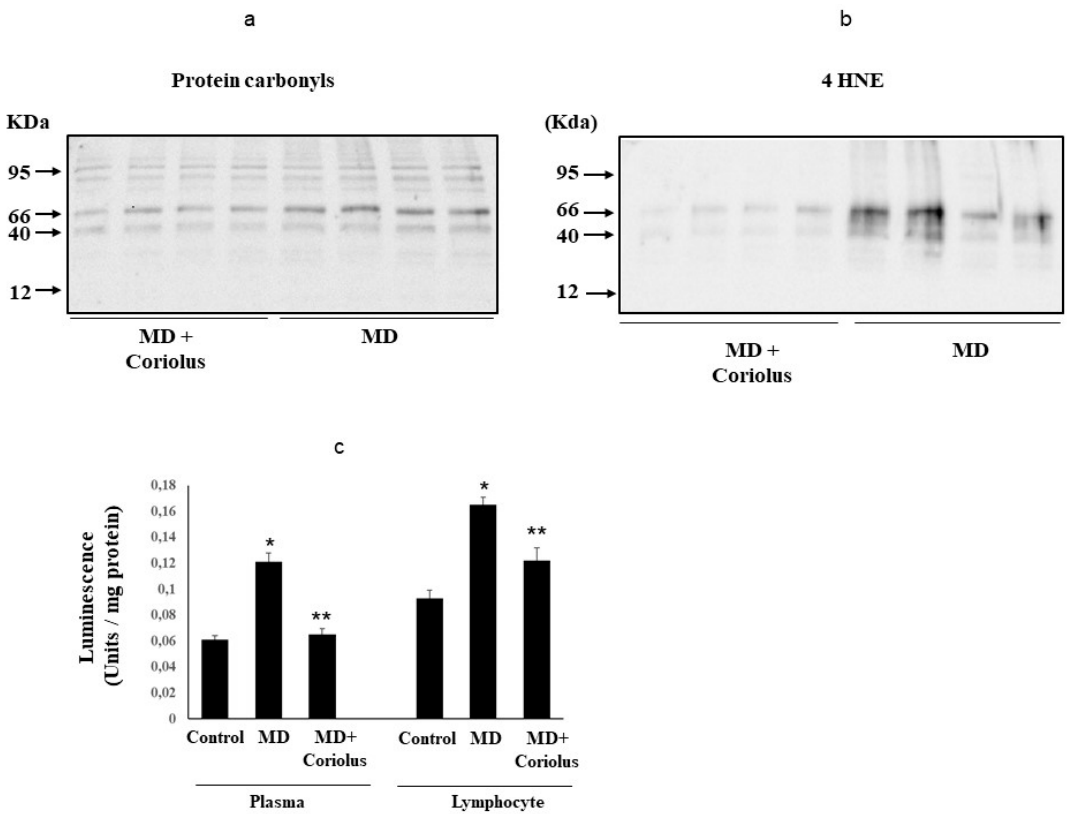
Figure 7. Protein carbonyls, 4-hydroxy-2-nonenals and Spontaneous ultraweak chemiluminescence (UCL) levels in MD patients. Plasma samples from MD patients ( a , b ) were assayed for protein carbonyls (DNPH) and 4-hydroxy-2-nonenals (HNE) by Western blot as described in Materials and Methods. Values are expressed as mean ± SEM of independent analyses on 22 patients (MD plus Coriolus biomass) and, respectively, on 18 patients (MD alone), per group. * p < 0.05 vs. MD alone. D.U., densitometric units. UCL in plasma and lymphocytes of control healthy volunteers and Meniere Diseased (MD) patients, in the absence and presence of Coriolus biomass treatment is shown in ( c ). UCL was measured as described in methods. CTRL: control; MD: Meniere disease patients. (*) p < 0.05 vs. control; (**) p < 0.05 vs. MD alone.